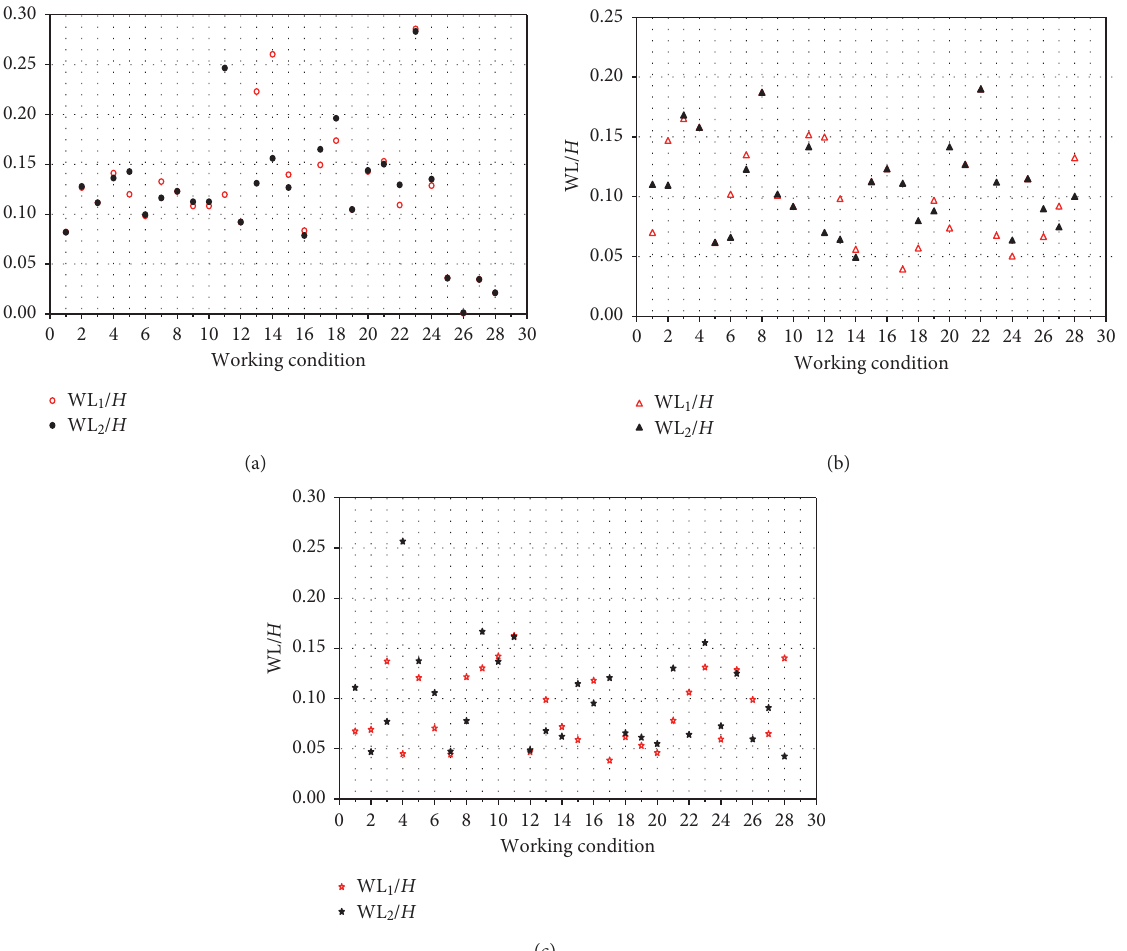
Figure 13: Width coefficient of influence along the X axis of continuous collapse of masonry structure under various working conditions. (a) The three-story masonry structure along the X axis, (b) the five-story masonry structure along the X axis, and (c) the seven-story masonry structure along the X axis.